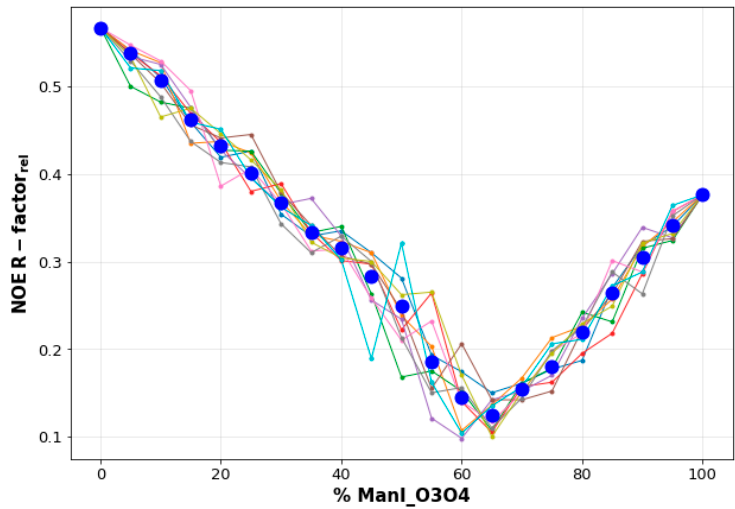
Figure 6. The fit of the NOE R-factor rel value computed by BM_Mixer to the relative population of ManI_O3O4 frames. Obviously, the percentage of the alternative binding mode ManI_O4O3 is 100 − % ManI _ O 3 O 4). The quantitative STD data predicted by CORCEMA-ST for 800 frames from the MD simulations were employed. Each colored line represents a different iteration of the main loop of the program (only 10 out of 20 are shown for clarity). Blue circles represent the mean value among all iterations for that particular combination of binding modes (BM). The minimum is reached for an ensemble of structures formed by 65% of ManI_O3O4 and 35% of ManI_O4O3. All the assigned experimental STD intensities were used in the calculations. In this case, 400 frames from the ManI_O4O3 trajectory and 400 frames from the ManI_O3O4 trajectory were employed.